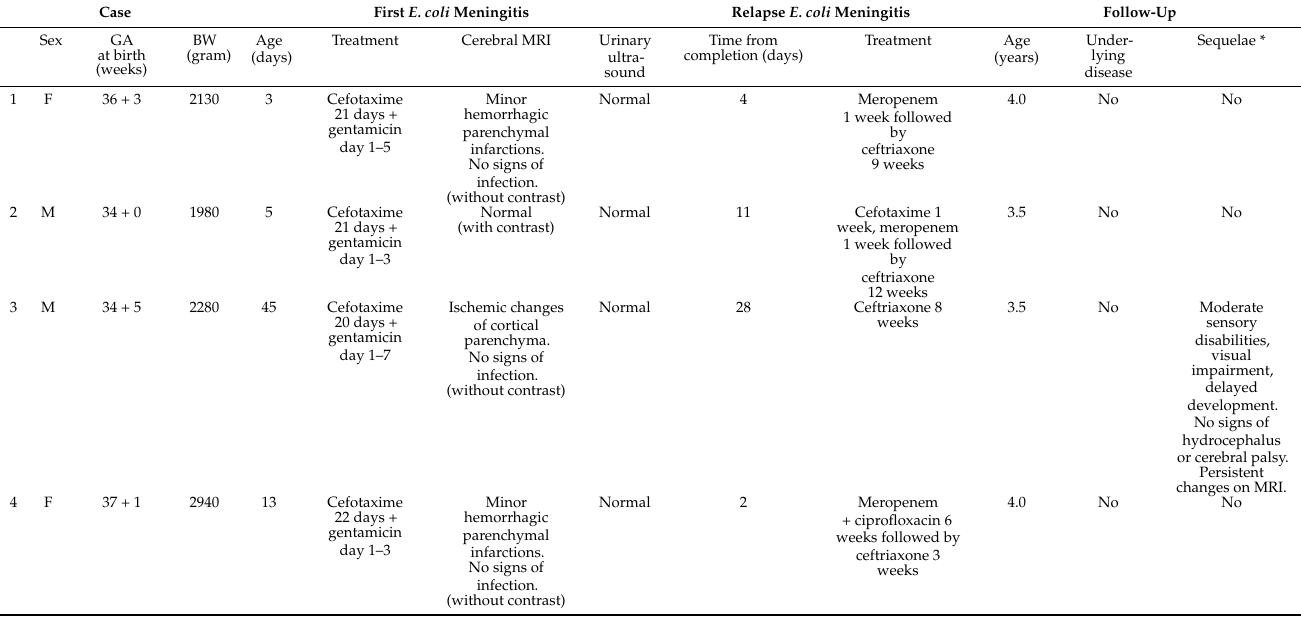
Table 1. Cases of relapse of neonatal Echerichia coli